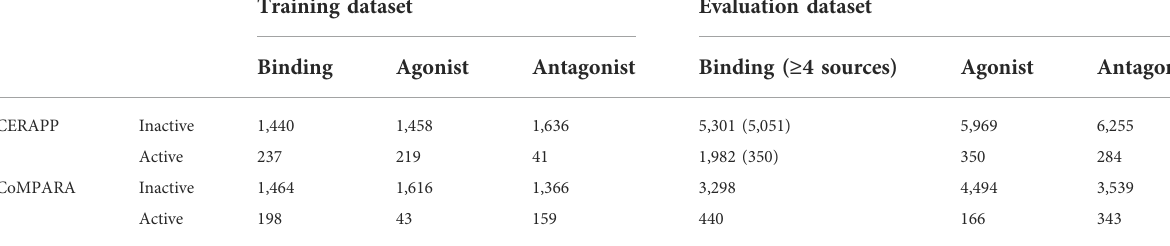
TABLE 1 Information for binary receptor activity for the training and evaluation datasets.